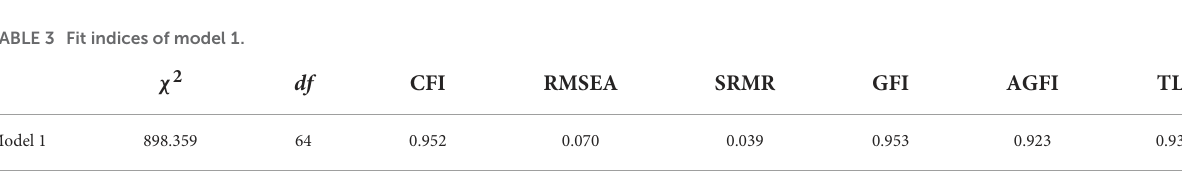
TABLE 3 Fit indices of model